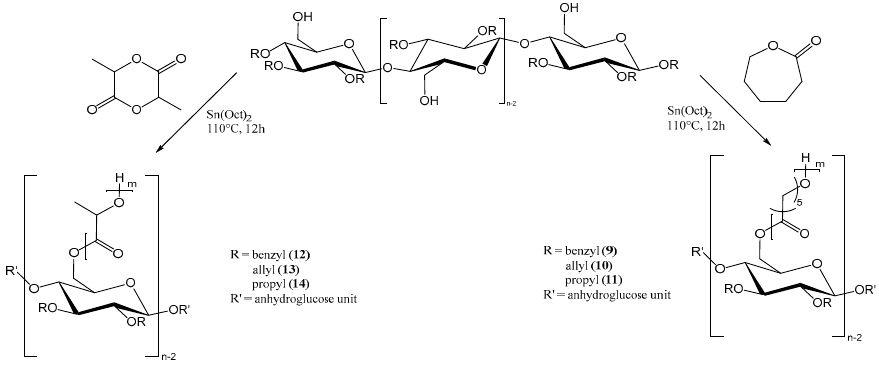
Figure 2. “Grafting from” polymerization of ε -caprolactone- or L-lactide monomers from function- alized cellulose macroinitiators.